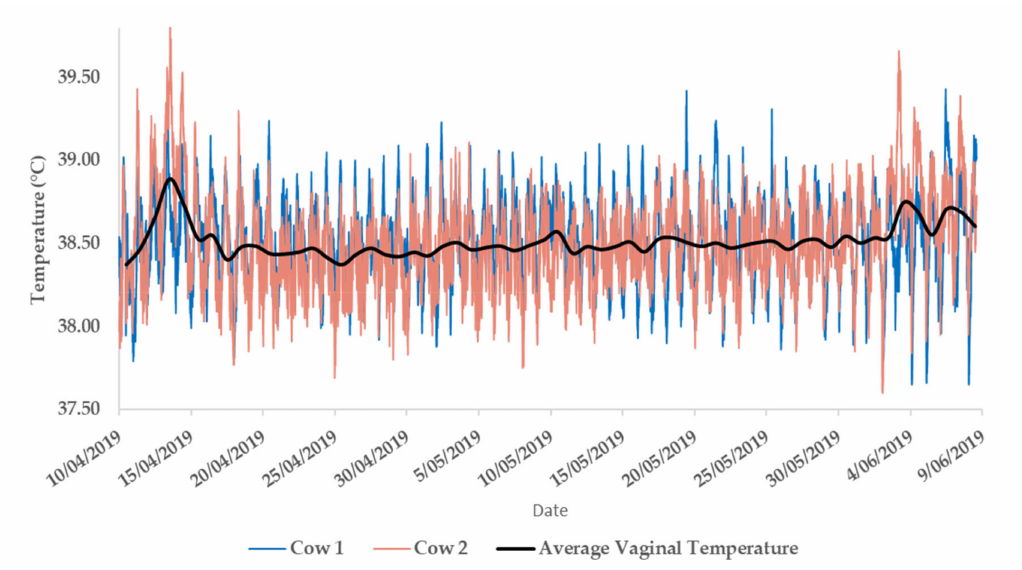
Figure 5. Vaginal temperature recorded at 5-min intervals from two cows in Trial 2, showing the diurnal pattern within days (pink and blue lines), and the daily average vaginal temperature (black line) to show variability across days for the 2-month period. Temperature data taken from April to June 2019.